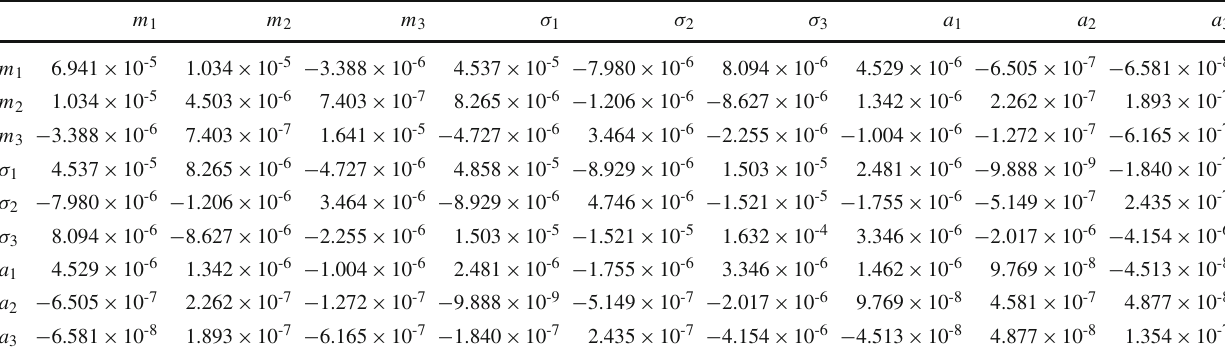
Table 5 Covariance matrix for the parametrization of the energy-loss function for molecular tritium, as provided in Table 2